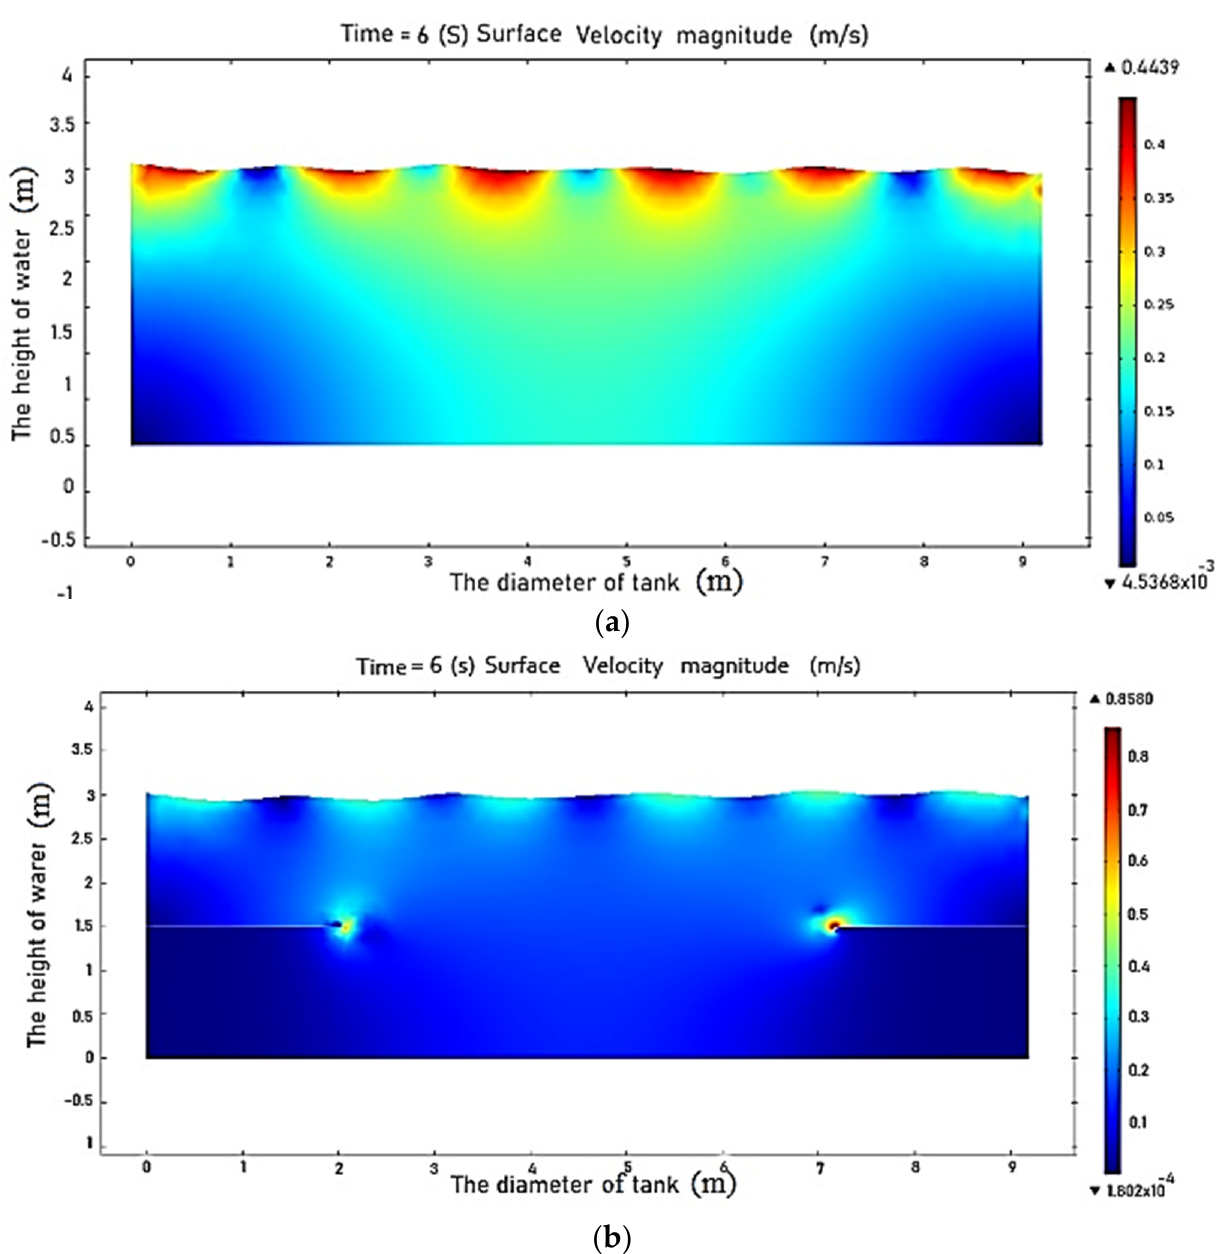
Figure 10. Two-dimensional diagram sloshing of the fluid surface with/without baffle. ( a ) Two-di- mensional diagram of no baffle sloshing of the fluid surface at T = 5 (s); ( b ) two-dimensional diagram of the baffle sloshing of the fluid surface at T = 5 (s).